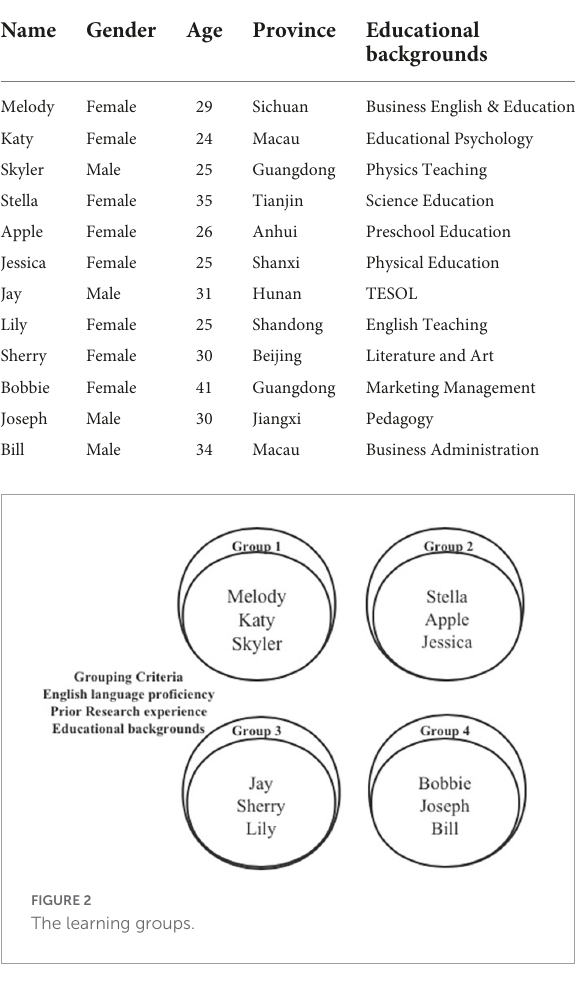
TABLE 1 Participants’ information.